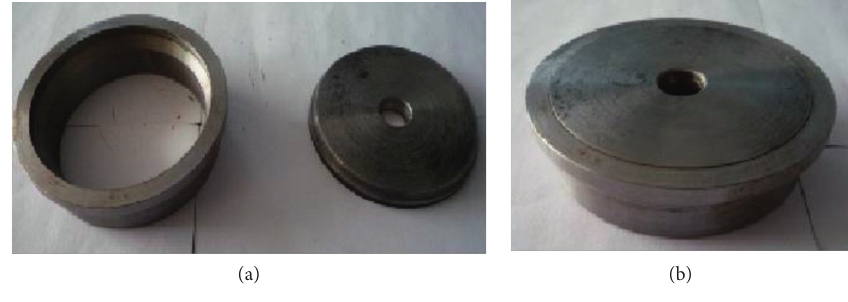
Figure 10: Physical drawing of buffer No. 2.